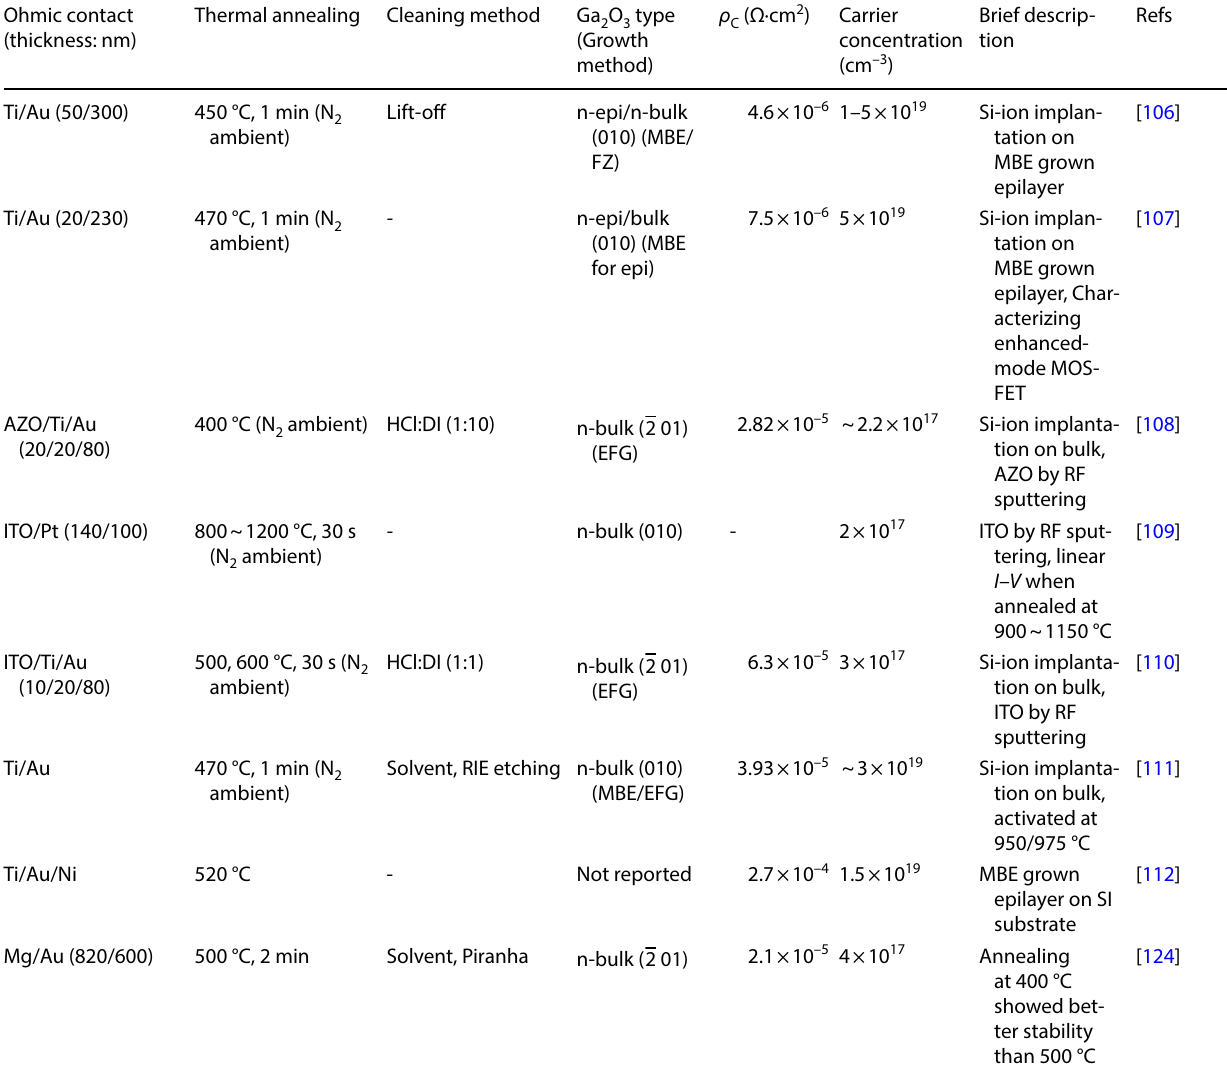
O reported in the 2 3